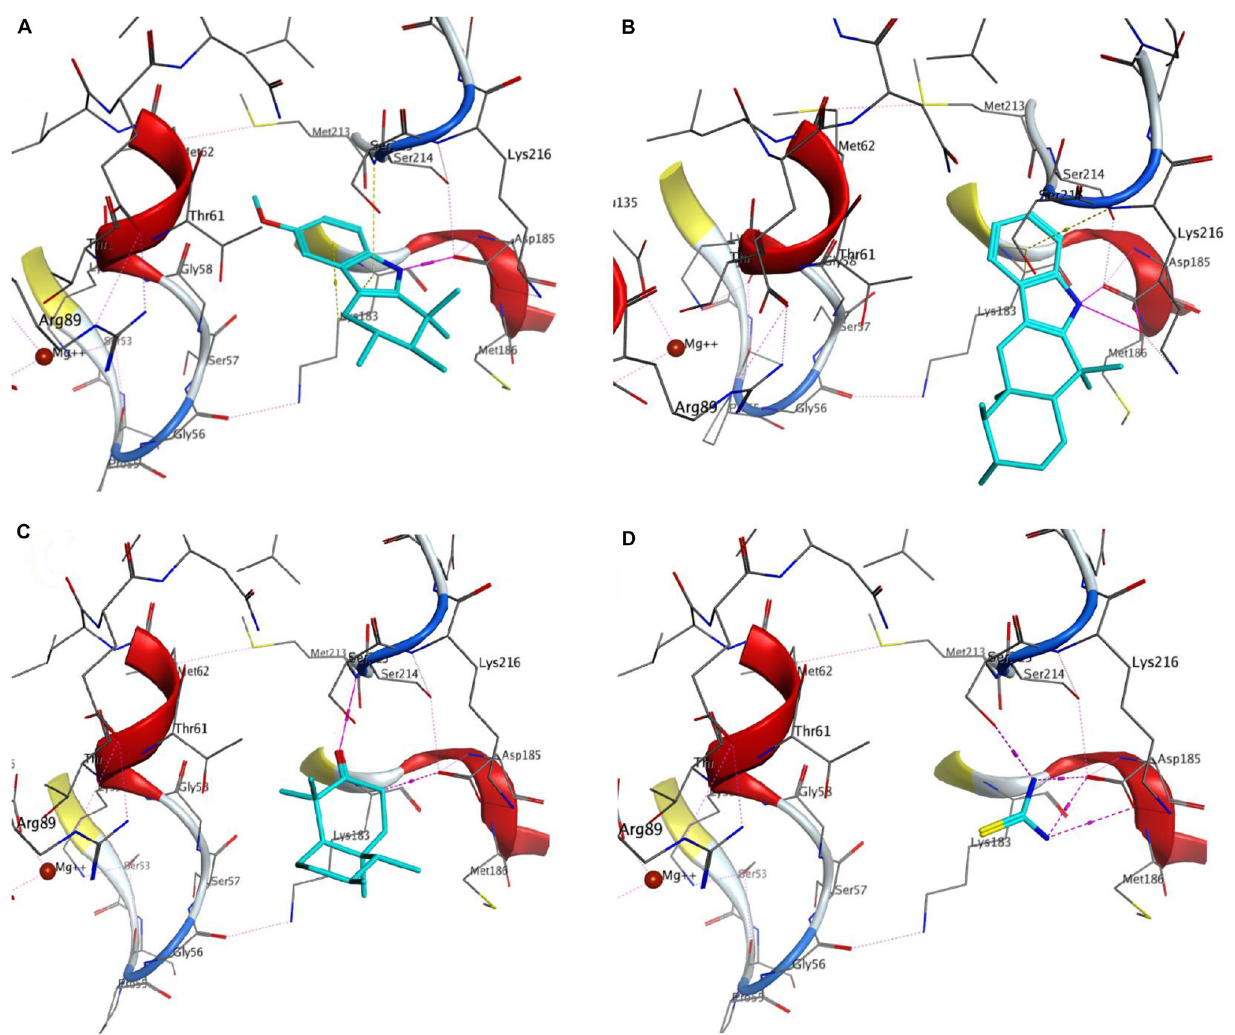
Fig. 3 Docking poses of a 3 , b 2 , c 1 and d Thiourea. Docked molecules are shown as light blue while the amino acid residues around the receptor pocket are shown as sticks. Hydrogen bonds and hydrophobic- p interactions are shown as dash magenta and yellow lines respectively